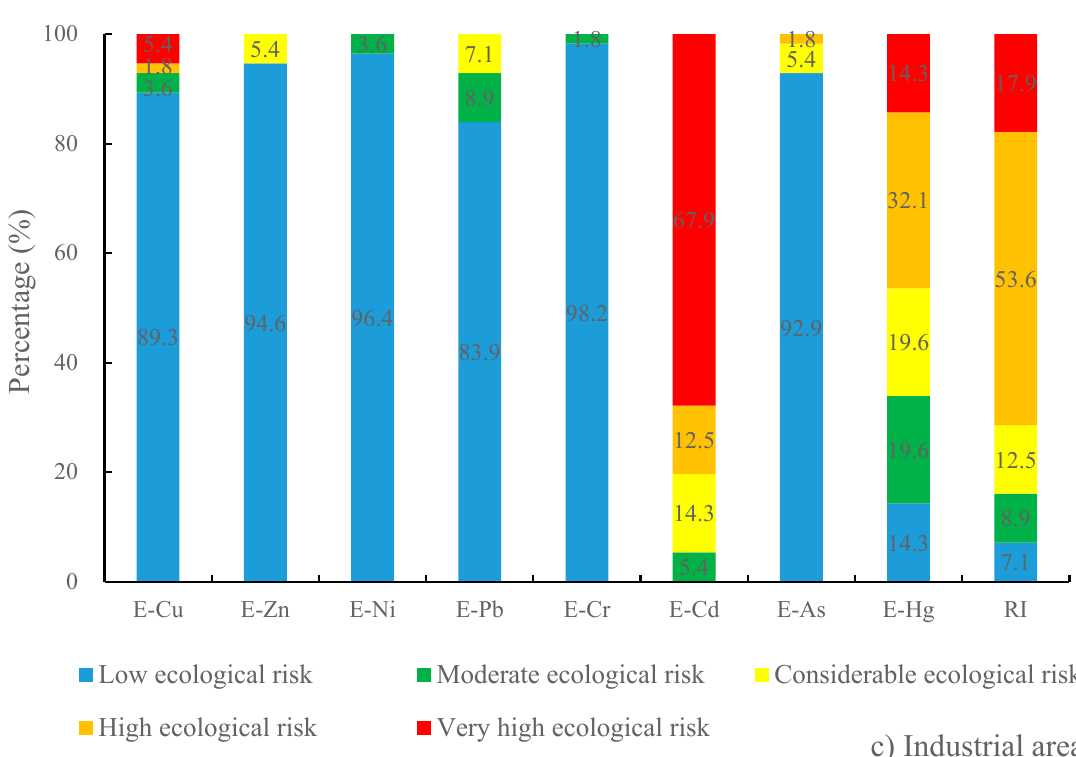
Figure 4. Percentage composition of different potential ecological risks caused by soil heavy metal based on calculation results of E for every element and RI for eight heavy metals: ( a ) city parks, ( b ) landfill, and ( c ) industrial area.